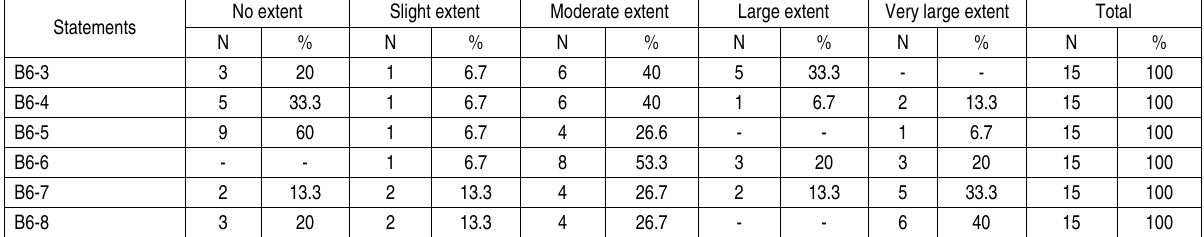
Table 6 (cont.). Perception of respondents on statements relating to logistic management